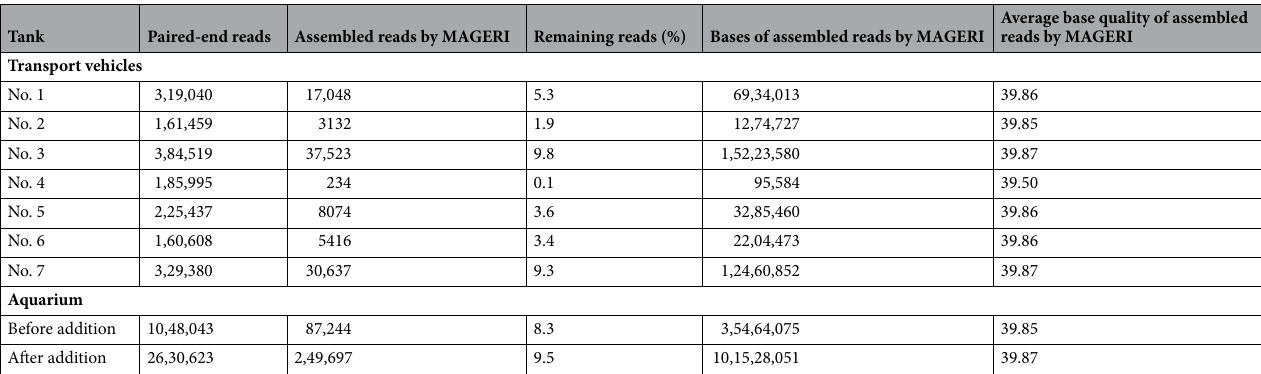
Table 2. Statistics on sequence data with the UMI tags. The number of reads and the number and percentage of reads assembled by MAGERI are shown.